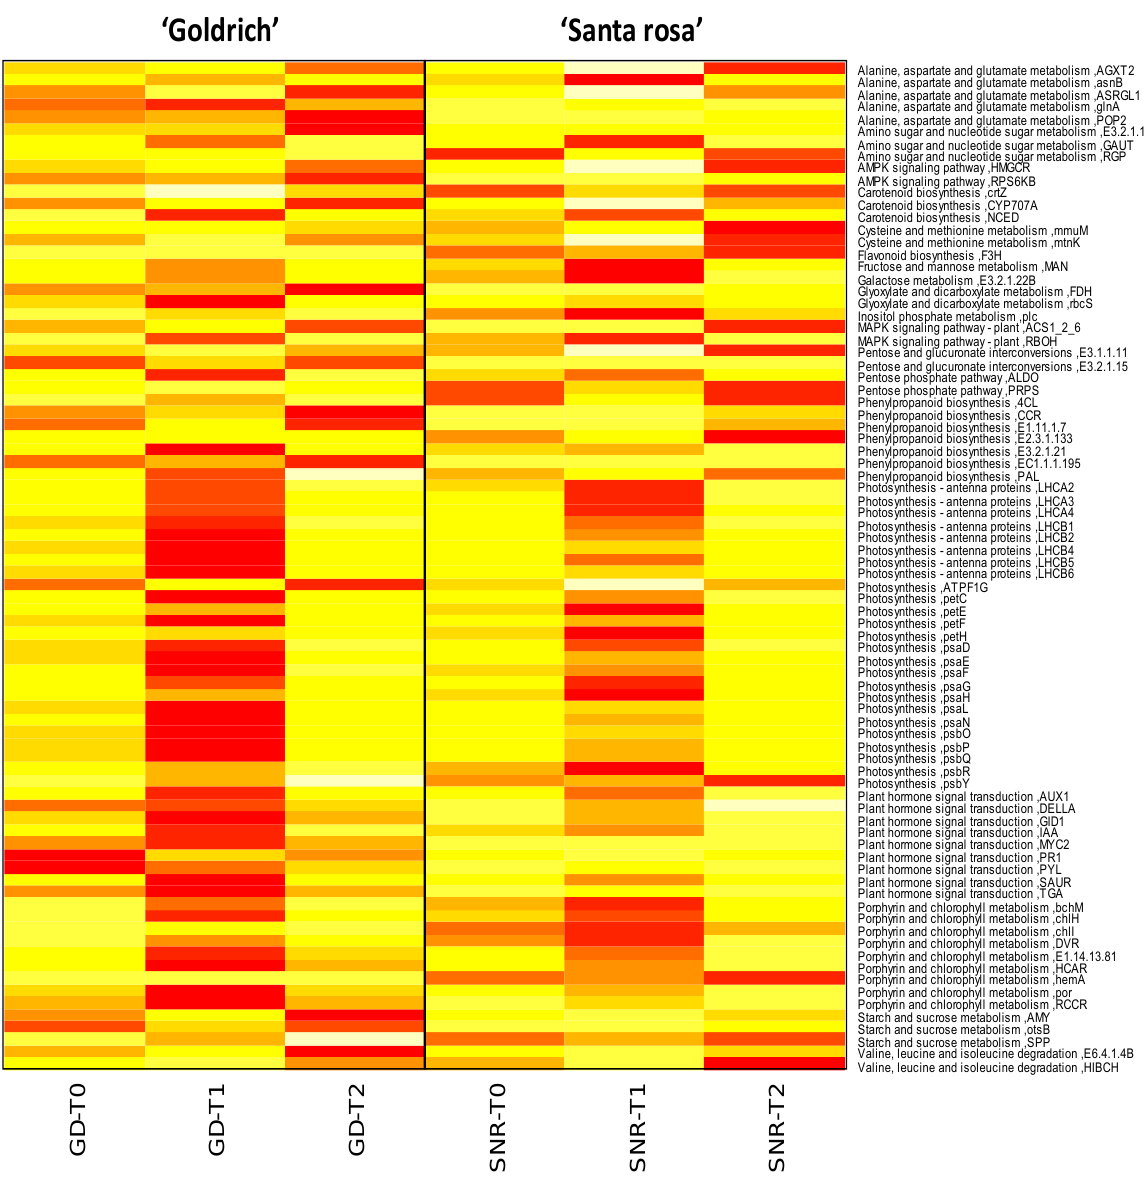
Figure 7. Gene expression of the most significant genes (DEGs, − 1 > log2FC > 1; p -value < 0.005) and its homologous protein common in both species Prunus armeniaca (‘Goldrich’) and Prunus salicina (‘Santa Rosa’) for each treatment (control, T0; 1-MCP, T1; Ethrel, T2). Red indicates a maximum value of fragments per kilobase of exon model per million reads mapped (FPKM), while light yellow indicates a minimum FPKM.